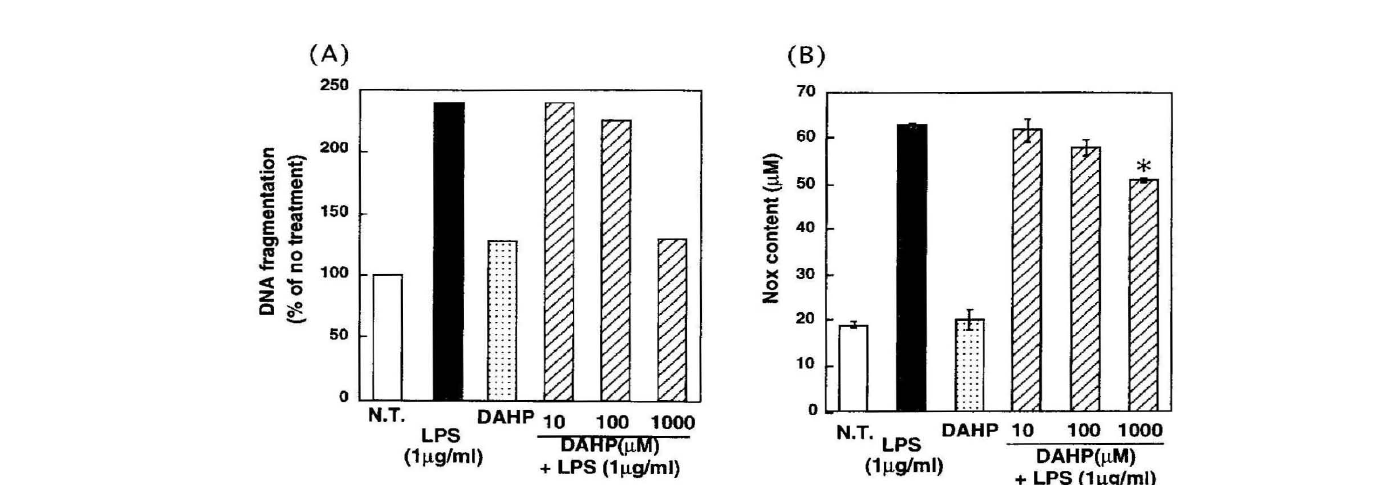
figure 1. Effect of DAHP on LPS-induced apoptotic cell death ofRAW264.7 cells. (A) Degree of DNA fragmentation and lOs B) NOx content in cultured medium. Cells (4x celis/well) were incubated with LPS (1 I-lg/ml), DAHP (1000 I-lM), -lnd LPS (l I-lg/ml) plus DAHP (10-1000 I-lM) for 24hr. (A, B). Each column in Figure 1 (B) represents the :nean±S.E.M. of quadruplicate assays. The statistical significance of differences compared with LPS alone group +p<O.OS) was determined by means of Student's t-test. ~.T., no treatment. Pteridines / Vol. 10 /